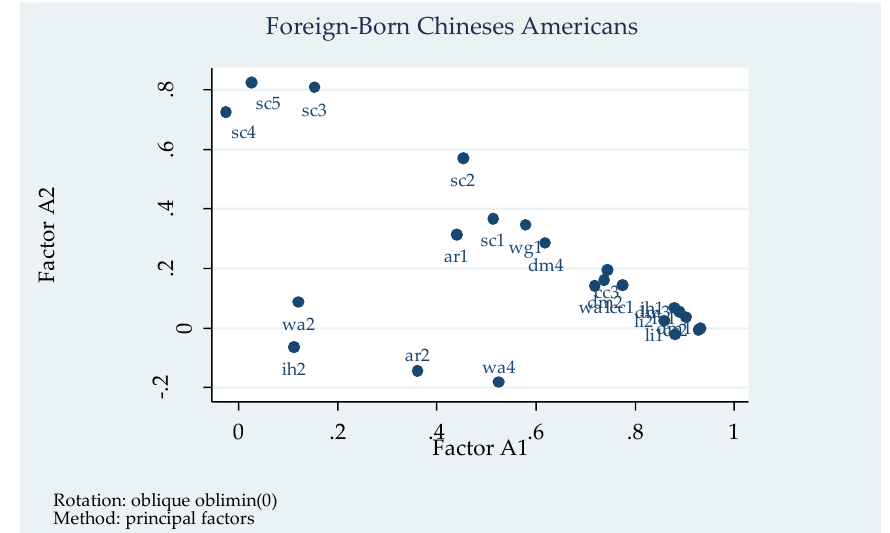
Figure 1. Factor Loading Plot